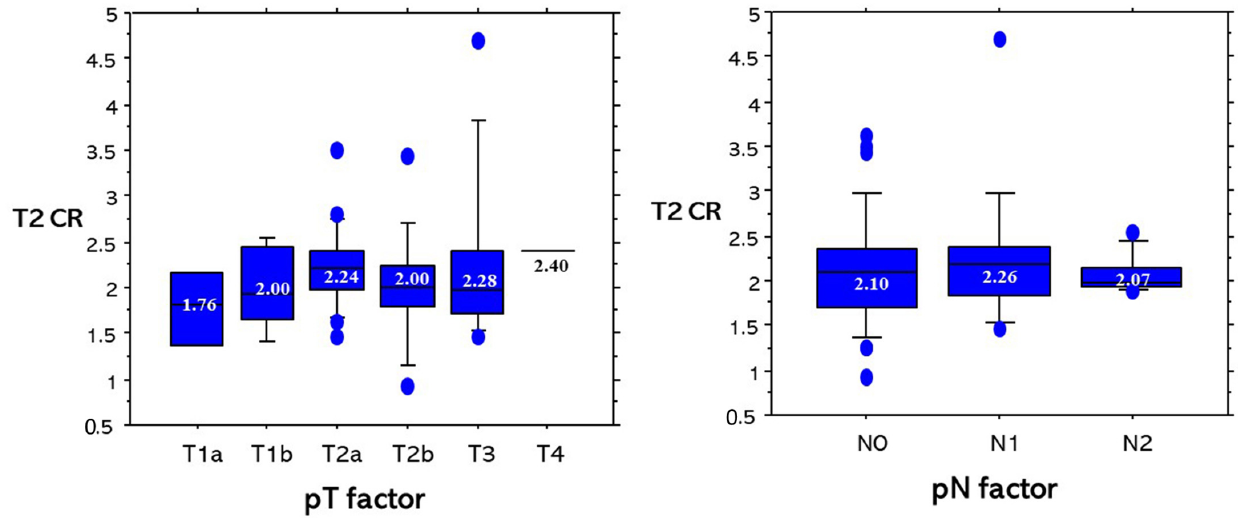
Figure 5. T2 WIs based on each diagnosis of PNMs. The T2 CR (2.14 ± 0.63) of lung cancer was